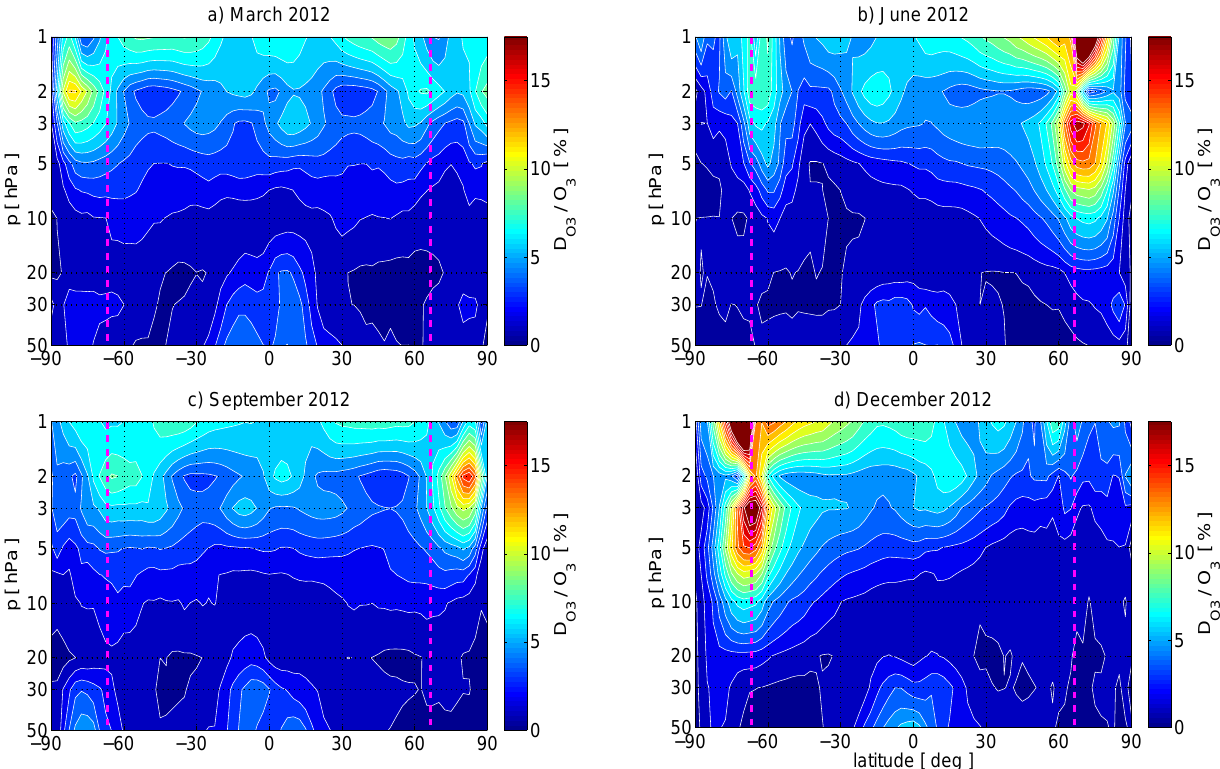
Figure 2. Zonal-mean D O /O 3 as function of latitude and pressure derived from MACC reanalysis. The figure shows 3 monthly means in the middle and upper stratosphere for ( a ) March, ( b ) June, ( c ) September, and ( d ) December of 2012 (according to Equation (7)). The dashed, magenta lines refer to the polar